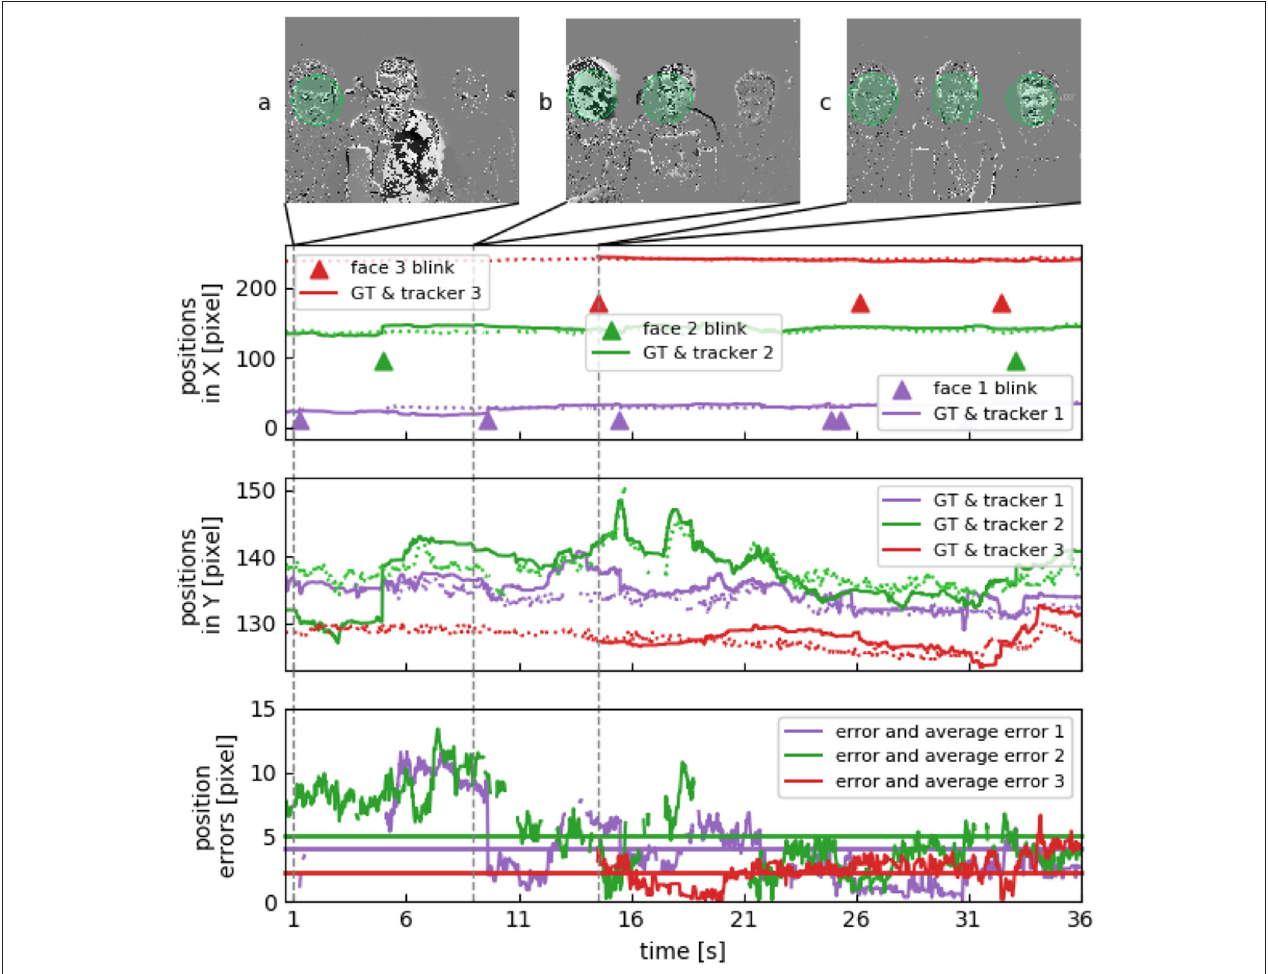
FIGURE 7 | Multiple face tracking in parallel. Face positions in X and Y show three subjects sitting next to each other, their heads are roughly on the same height. (A) Subject to the left blinks at first. (B) Subject in the center blinks next, considerably varying their face orientation when looking at the other two. (C) Third subject stays relatively still.